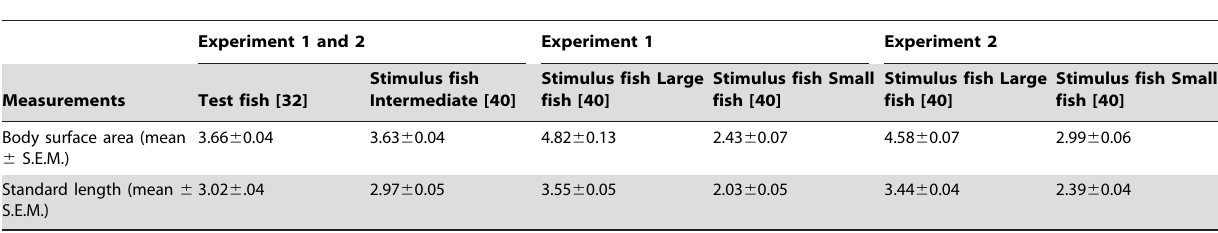
Table 1. Body surface area and length of the